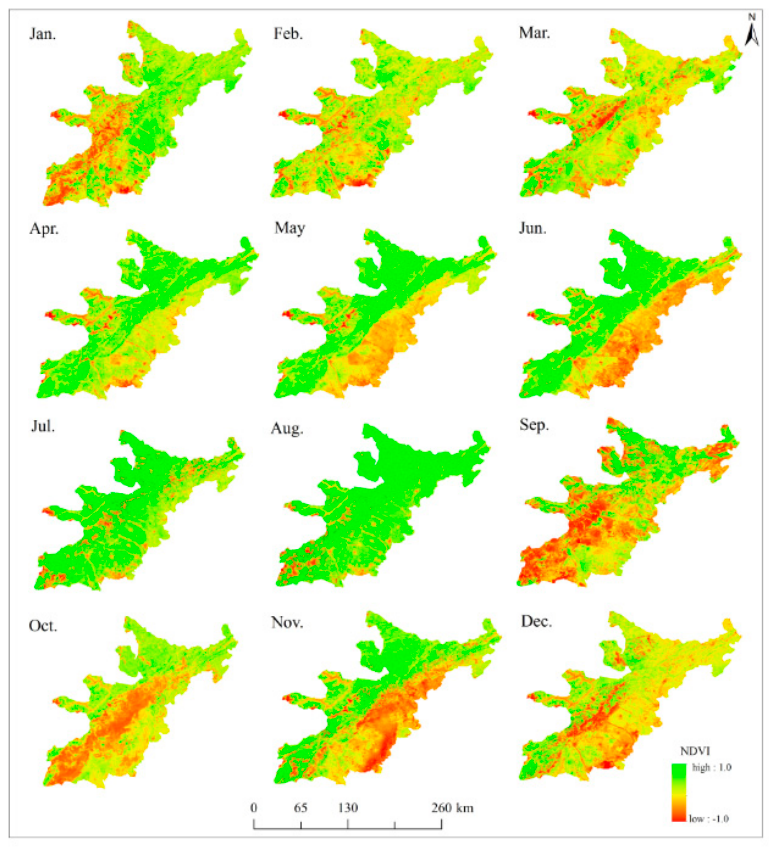
Figure 5. Inter-monthly NDVI averages in the Wenchuan epicenter in 2007.